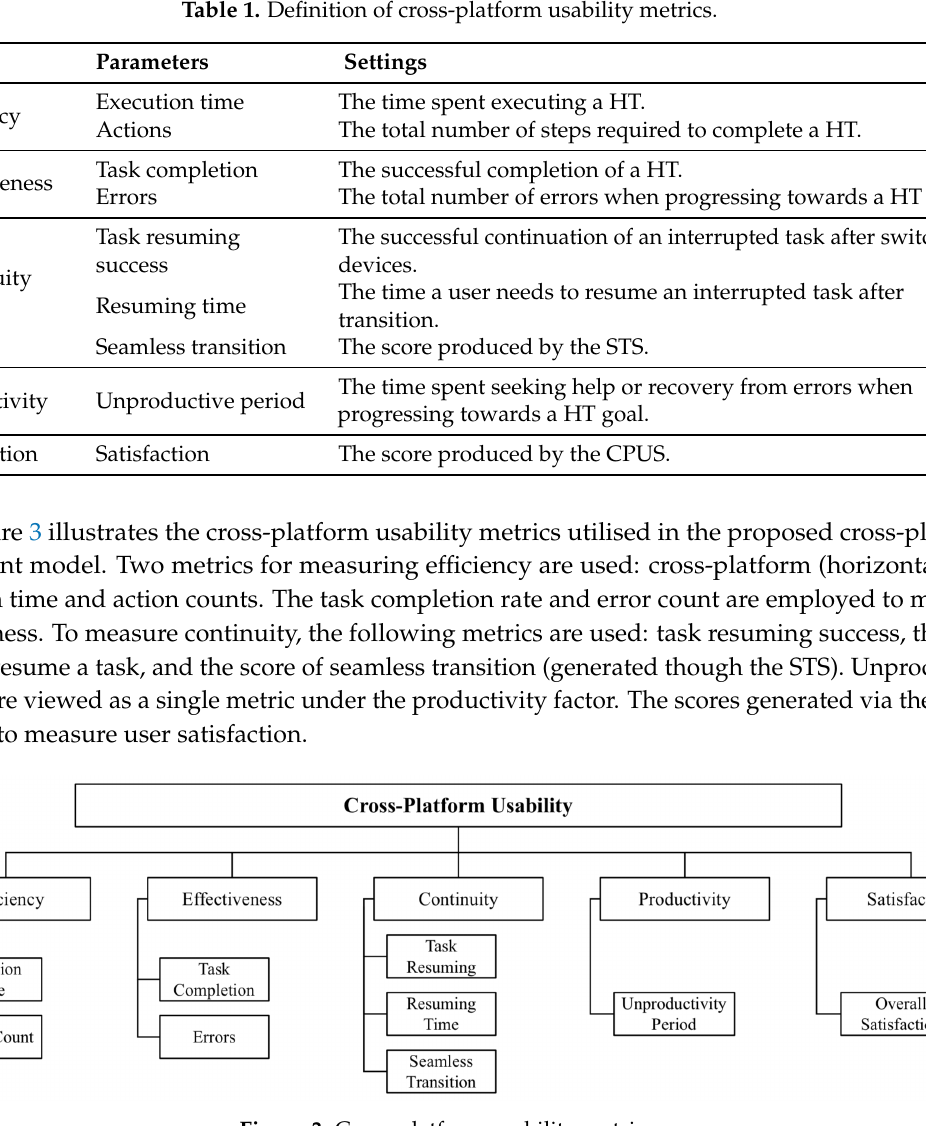
Figure 3. Cross-platform usability